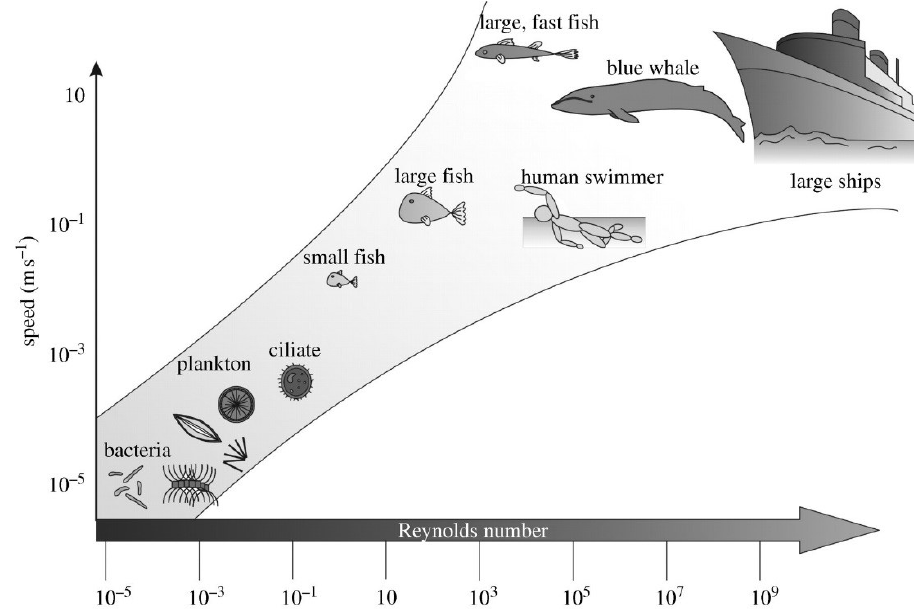
Figure 1. Reynolds numbers for various marine biofoulers and other relevant species and systems (e.g., fish, large mammals, ships). Reproduced from reference [11], with permission. Copyright (2010) The Royal Society.